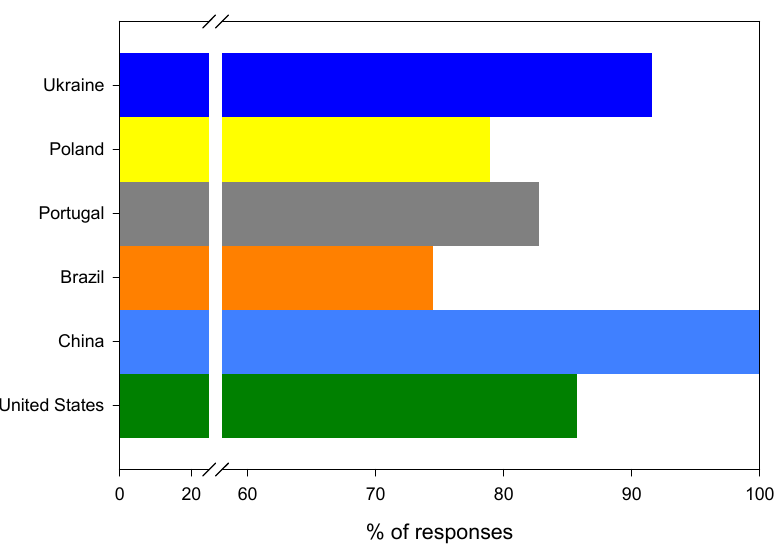
Figure 7. The distribution of positive answers to the question: Would you expect a clear notice on the bioplastic packaging that will allow you to choose between traditional plastic and biodegrad- able plastic?